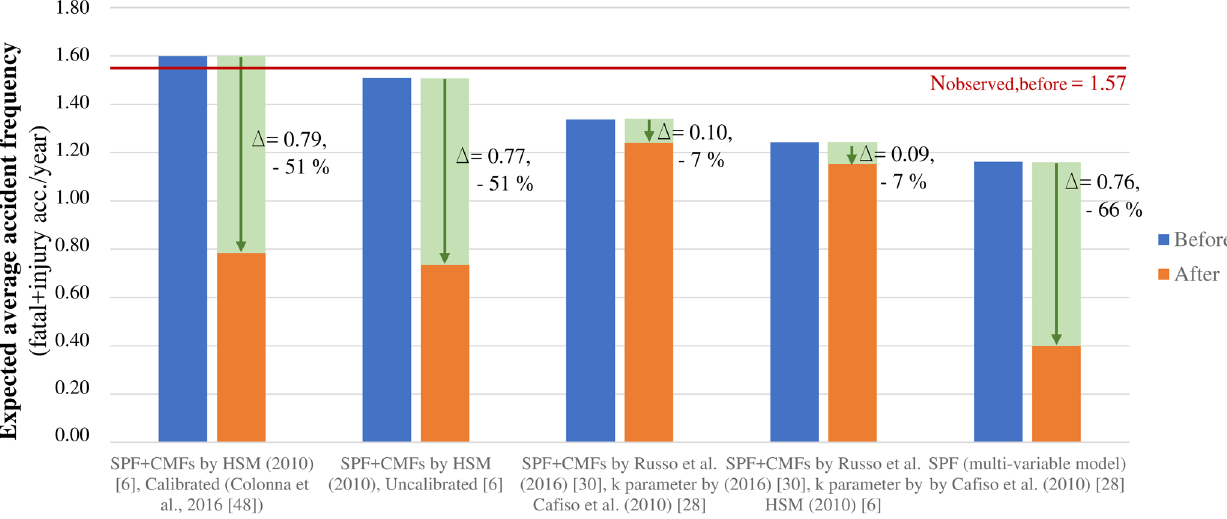
Fig. 14 Expected average accident frequencies on the PP1 site before and after the intervention (set of countermeasure D), by using three different predictive